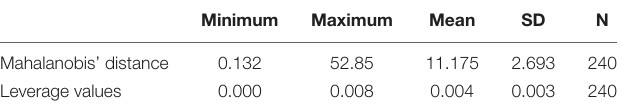
TABLE 4 | Outlier detection with Mahalanobis